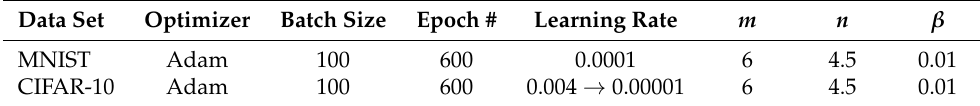
Table 2. Learned hyperparameter values for the supervised part of the biologically plausible model.